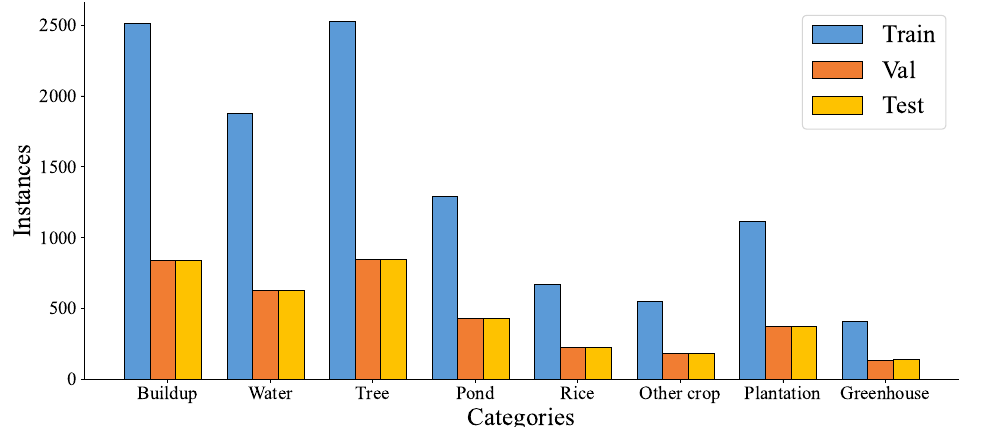
Figure 3. Class-label instances for Nanxun District sample